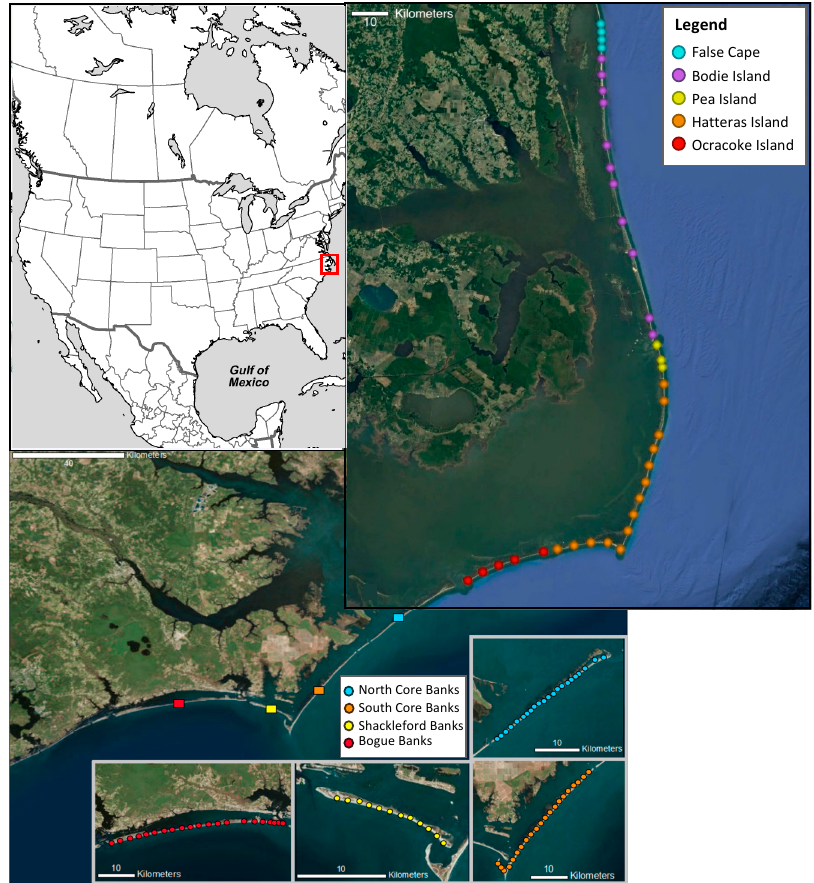
Figure 2. Map of the transect locations used to survey the distribution and abundance of foredune vegetation and the growth form and morphology of dune grass species along the barrier islands of the Outer Banks from False Cape, Virginia, to Bogue Banks, North Carolina, USA. Note that the transect locations for the southern islands are in the inset boxes at the bottom of the map.